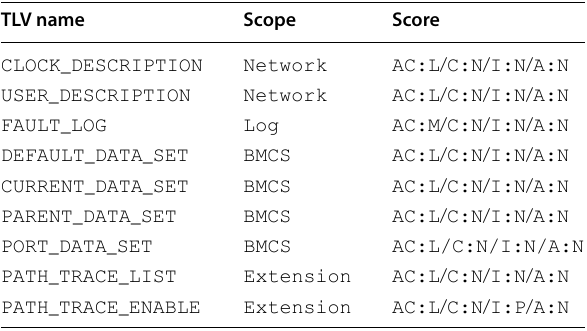
Table 2 PTP IEEE-1588 2008 TLVs that can be used in the Reconnaissance